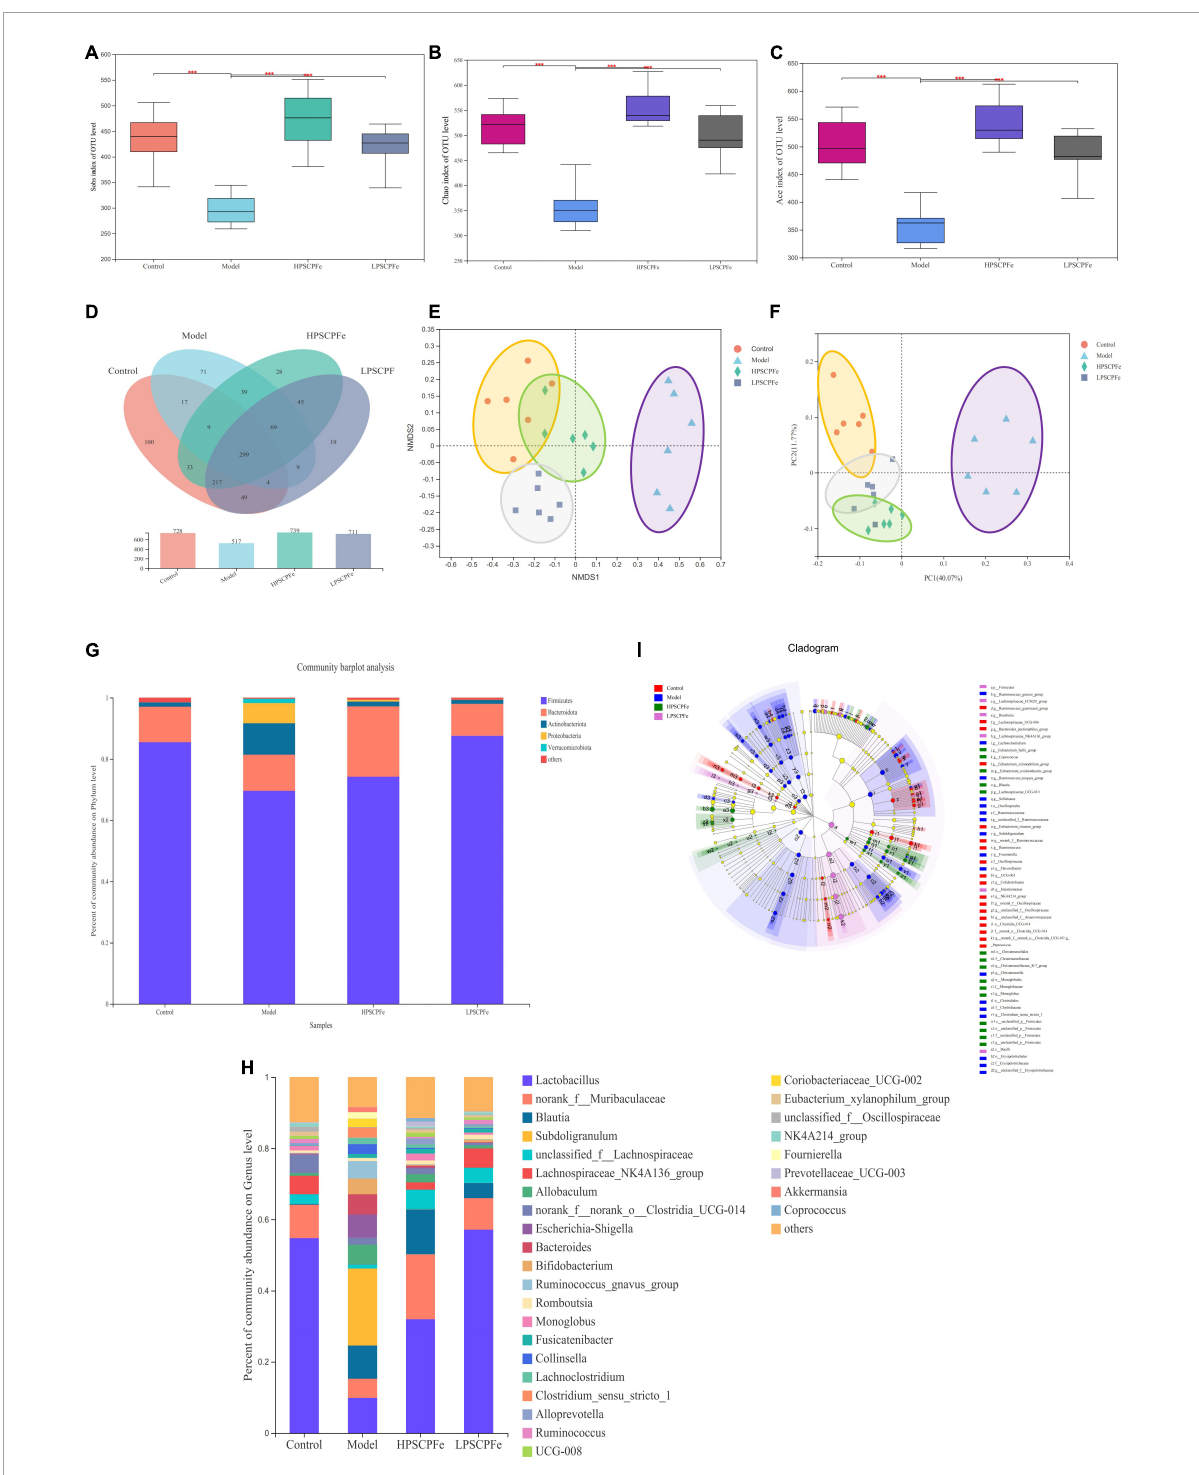
FIGURE3 PSCP-Fe treatment restored the distribution of gut flora composition in IDA rat. (A) The Sobs index of OTU level. (B) The Chao index of OTU level. (C) The Ace index of OTU level. In each group, n = 6. ∗∗∗ p < 0.001: control or treatment vs. model group. (D) Venn diagram of 16S rRNA based profiling. (E) Non-metric multidimensional scaling (NMDS) based on the Bray-Curtis dissimilarity. (F) Bray-Curtis PCoA of 16S rRNA based profiling. (G) Relative abundance of bacterial phylum. (H) Relative abundance of bacterial genus. (I) Taxonomic cladogram generated by LEfSe analysis showing taxa significantly enriched in control (red), model (blue), HPSCP-Fe (green), LPSCP-Fe (purple), respectively. Each ring represents a taxonomic level from phylum to genus. The diameter of each dot on the ring represents the relative abundance of the